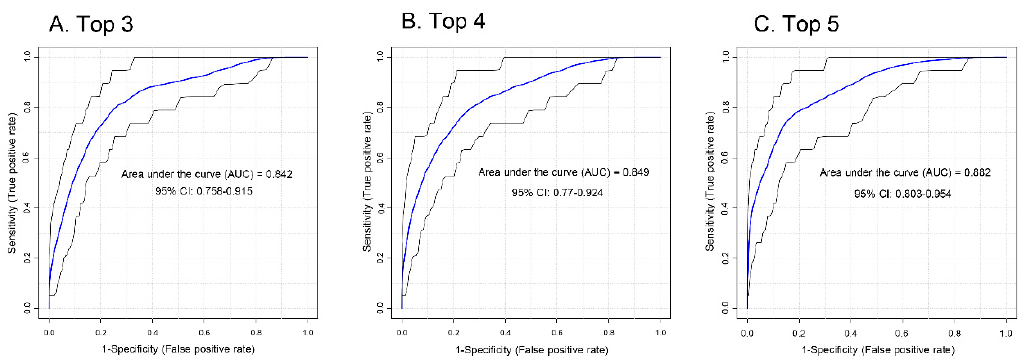
Figure 4. ROC analysis for sphingolipid association with PCa aggressiveness. ( A ) The top three most intense sphingolipids (tetrahexosylceramide (d18:1 / 16:0), sphingomyelin (d18:0 / 24:1), and trihexosylceramide (d18:1 / 16:0)), ( B ) top four (top three plus ceramide (d18:1 / 24:1)), and ( C ) top five (top four plus ceramide (d18:1 / 22:0)) sphingolipids were analyzed by ROC for association with aggressiveness.